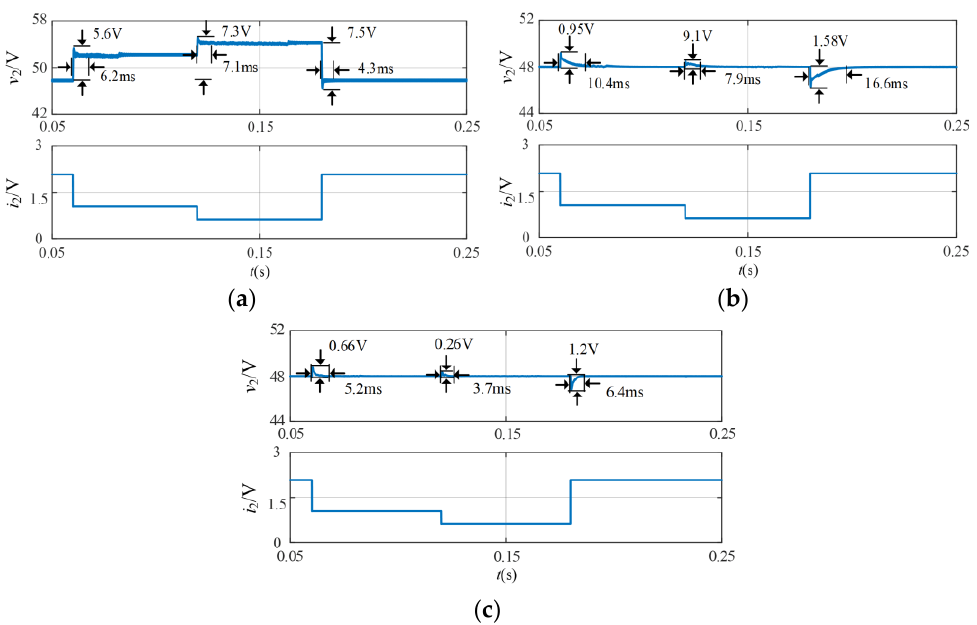
Figure 12. The dynamic waveforms of v 1 when i 1 changes in step-up mode: ( a ) PBC; ( b ) PBC with PI; ( c ) PBC with LADRC.